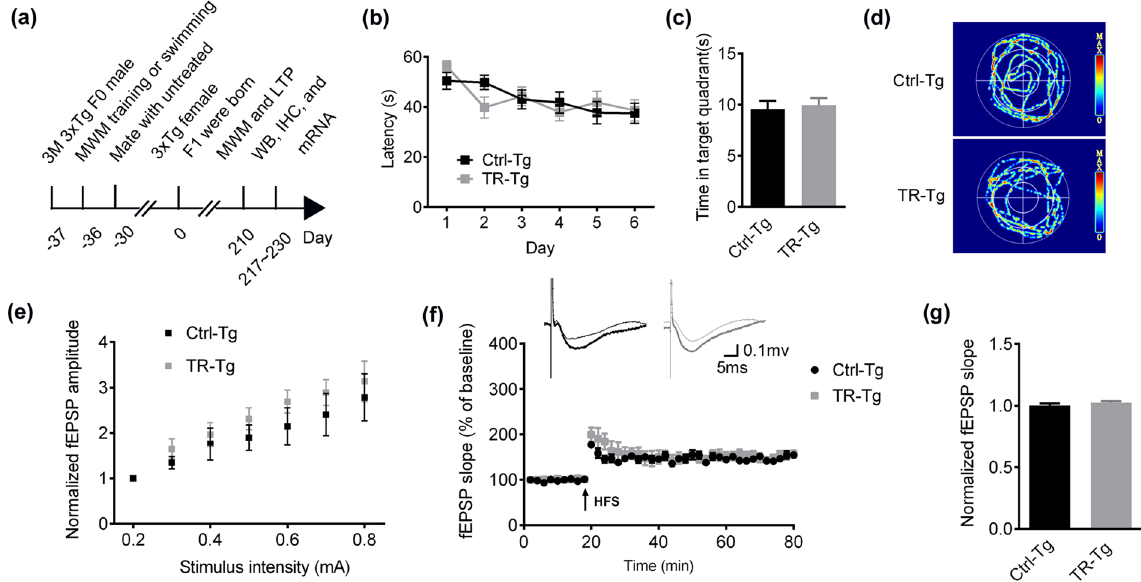
Figure 4. Paternal spatial training for 1 week does not improve cognitive performance and synaptic transmission in 3XTg F1 offspring. ( a ) Spatial training paradigm and the experimental procedures. The birth of F1 offspring was defined as day zero. 37 days ago, F0 males were collected and engaged to Morris water maze (MWM) training or swimming (control). Those who behaved well were selected to mate with untreated females after MWM. The F1 offspring from different cages were bred under the same maintenance. When offspring grew up to 7-m old, they were conducted with MWM, Electrophysiological analysis (LTP), Western blotting (WB), Immunohistochemistry (IHC) and mRNA extraction. ( b ) Escape latency to find the hidden platform in MWM during 6 days training trials (two-way ANOVA row factor, F 5,323 = 4.395, p = 0.0007; Bonferroni post hoc tests, n.s, n = 9 ~10 per group). ( c ) Quantitative analysis of time spent in the target quadrants. Bar graphs show mean ± SEM (two-tail t-test, n.s, n = 7~10 per group). ( d ) The swimming pathway in the maze recorded at day 8 after removed the platform. ( e ) The Input/Output (I/O) curve of the fEPSP in CA1 pyramidal neurons, normalized by fEPSP amplitude induced by minimum stimulation intensity (two-way ANOVA row factor, F 6,42 = 9.280, p < 0.0001; Bonferroni post hoc tests, n.s, 4 slices from 3 mice per group). ( f ) The slope of fEPSP after HFS normalized against the fEPSP slope before HFS (the baseline). Arrow indicates the onset of HFS (100 Hz, 1s duration). ( g ) Quantitative analysis of fEPSP slope. 6 values (fEPSP slopes against the baseline) around 60 min in each group were took for quantitative analysis. Bar graphs show mean ± SEM (two-tail t-test, n.s, 5 slices from 3 mice per